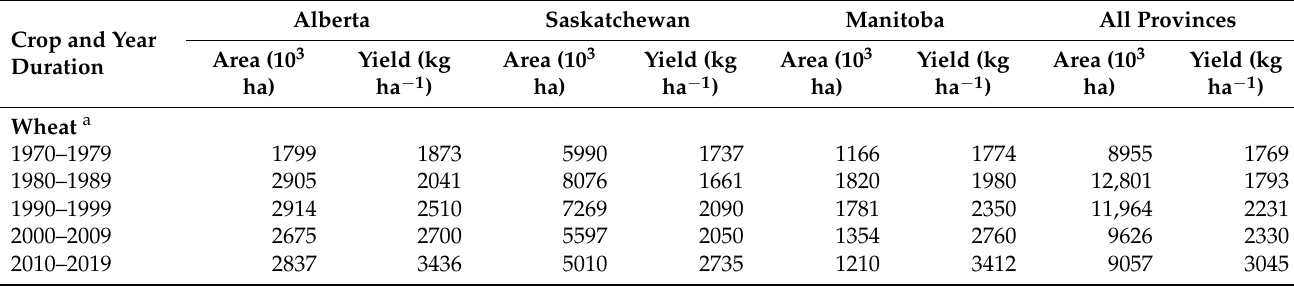
Table A2. Summary of seeded area and average yield for major field crops in Manitoba, Saskatchewan and Alberta from 1970 to 2019 (based on Statistics Canada [5]). Each value is an average for a period of every ten